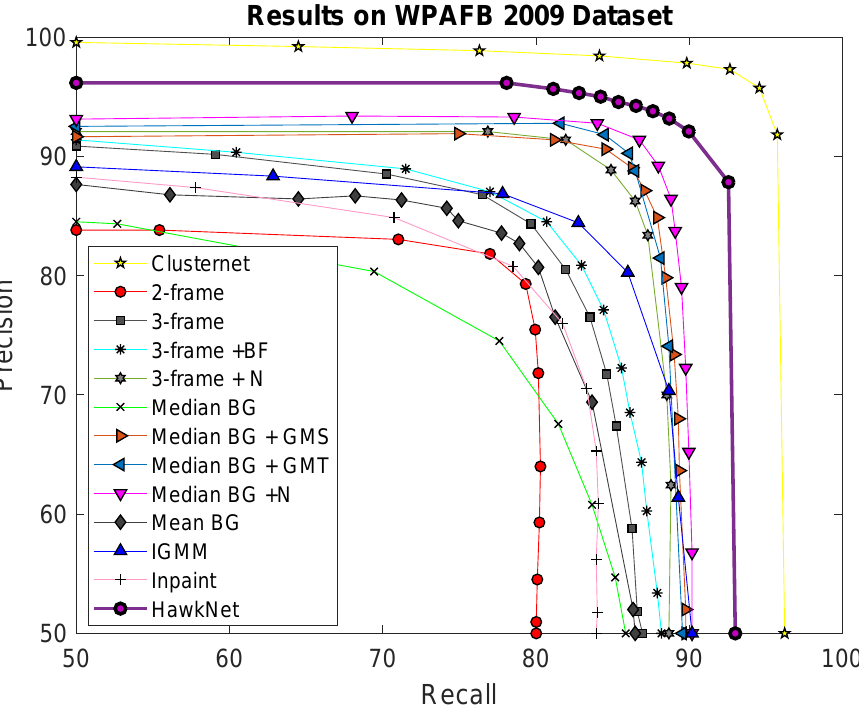
Figure 7. Comparison between the results achieved by our T-RexNet and other State-of-Art (SoA) approaches in the aerial surveillance (WAMI) scenario. We took the comparison in [31] and added the results of using T-RexNet. Despite Clusternet has better performance, our T-RexNet is ∼ 10 times faster. For information about the other methods we compare with refer to